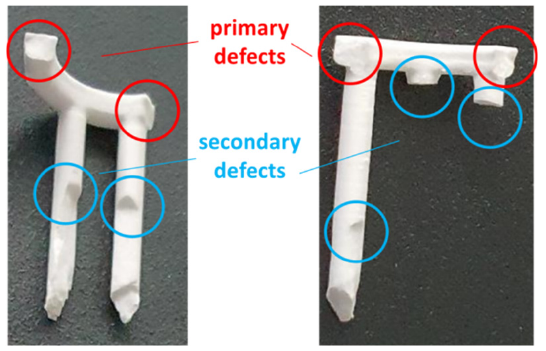
Figure 12. Experimental observed defects at the column structure.